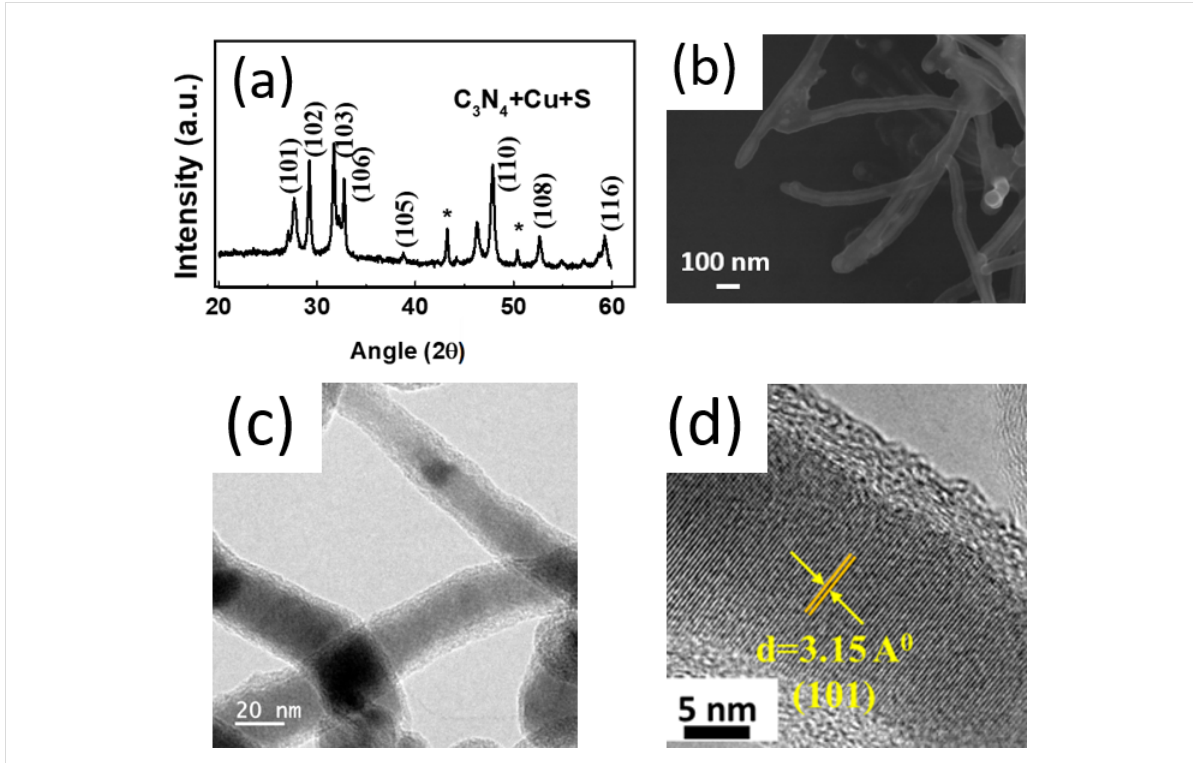
Figure 4: (a) XRD patterns of CuS nanorods synthesized in the presence of sulfur by microwave irradiation of copper in the presence of g-C 3 N 4 in a Teflon beaker for 2 min. (b) SEM, (c) TEM and (d) HRTEM images of CuS nanorods. The asterisk (*) in panel (a) indicates the reflections from Cu.